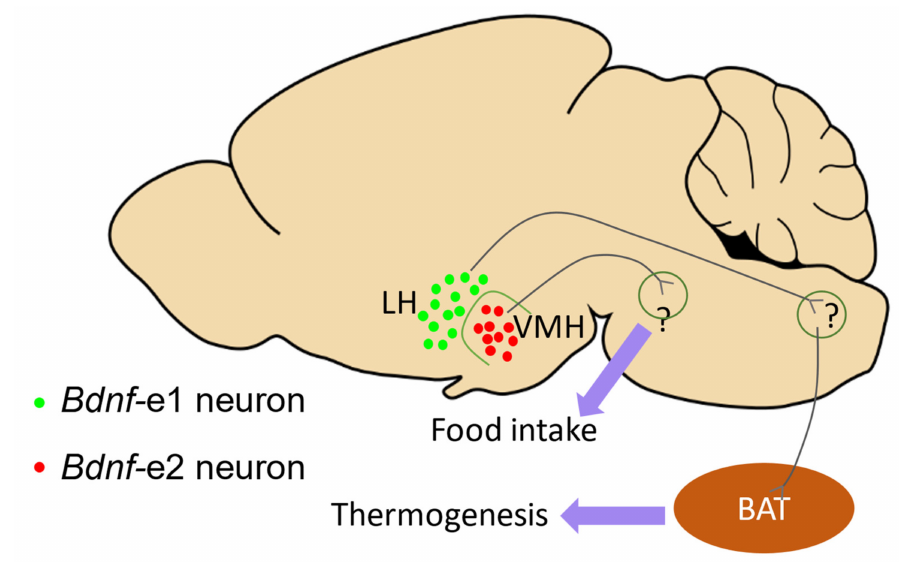
Figure 4. The function of BDNF driven by Promoters I and II in the energy balance. This diagram illustrates the hypothesis that BDNF driven by Promoters I and II may contribute to distinct aspects of the energy balance, according to studies by [7,23]. The distribution of Bdnf -e1 (green dots) and Bdnf -e2 (red dots) neurons in the lateral hypothalamus (LH) and ventral medial hypothalamus (VMH), and their potential roles in energy balance are shown. Bdnf -e1 neurons in LH are suggested to indirectly regulate brown adipose tissue (BAT, brown ellipse) and contribute to thermogenesis, while Bdnf -e2 neurons in VMH are postulated to control